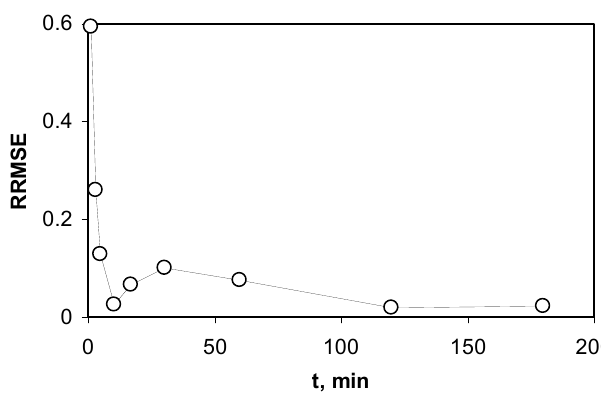
Figure 10. RRMSE values for approximation of kinetic data by the PSO equation.